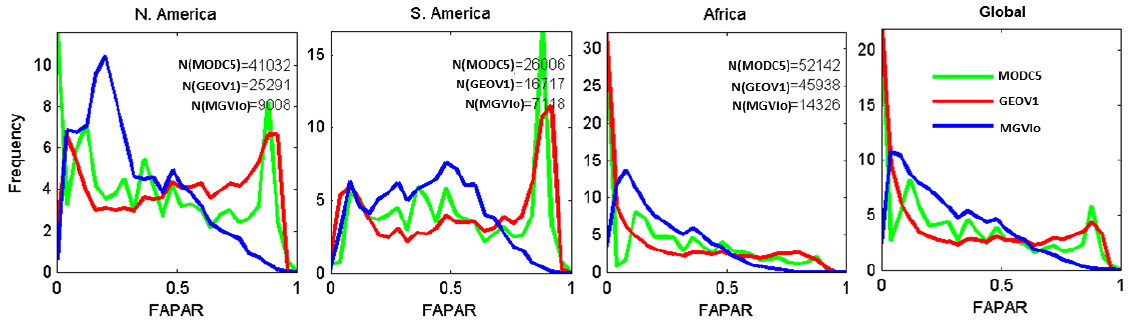
Figure 10. Distribution of FAPAR product value per continent (only N. America, S. America and Africa are displayed) and globally (GLOBAL). GEOV1 (red), MGVIo (blue) and MODC5 (green). For each product, N is the number of observations that were used to compute the distribution. Computation is performed over the BELMANIP2.1 sites (49 × 49 km 2 ), during the periods defined in Table 2, and for the original temporal